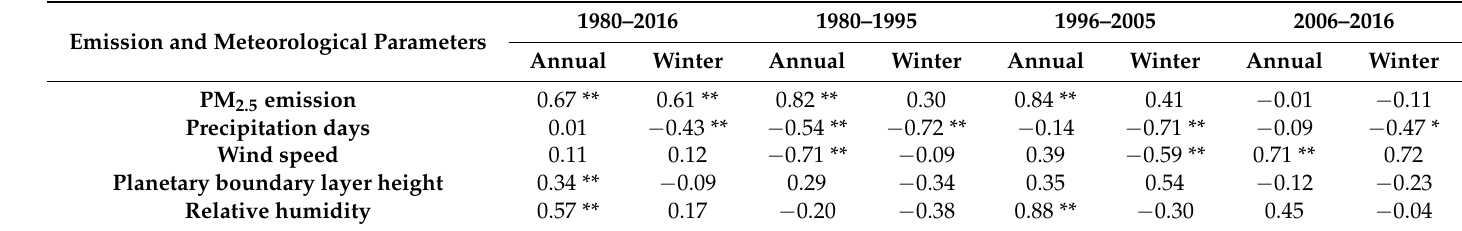
Table 2. Correlation coefficients between spatially averaged HDs and meteorological parameters and PM 2.5 emission over SCB for the four periods: (a)